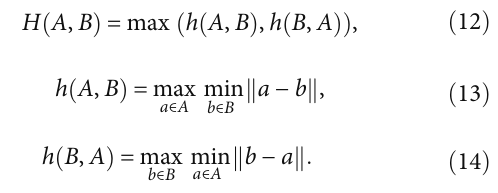
Figure 5: Schematic diagram of